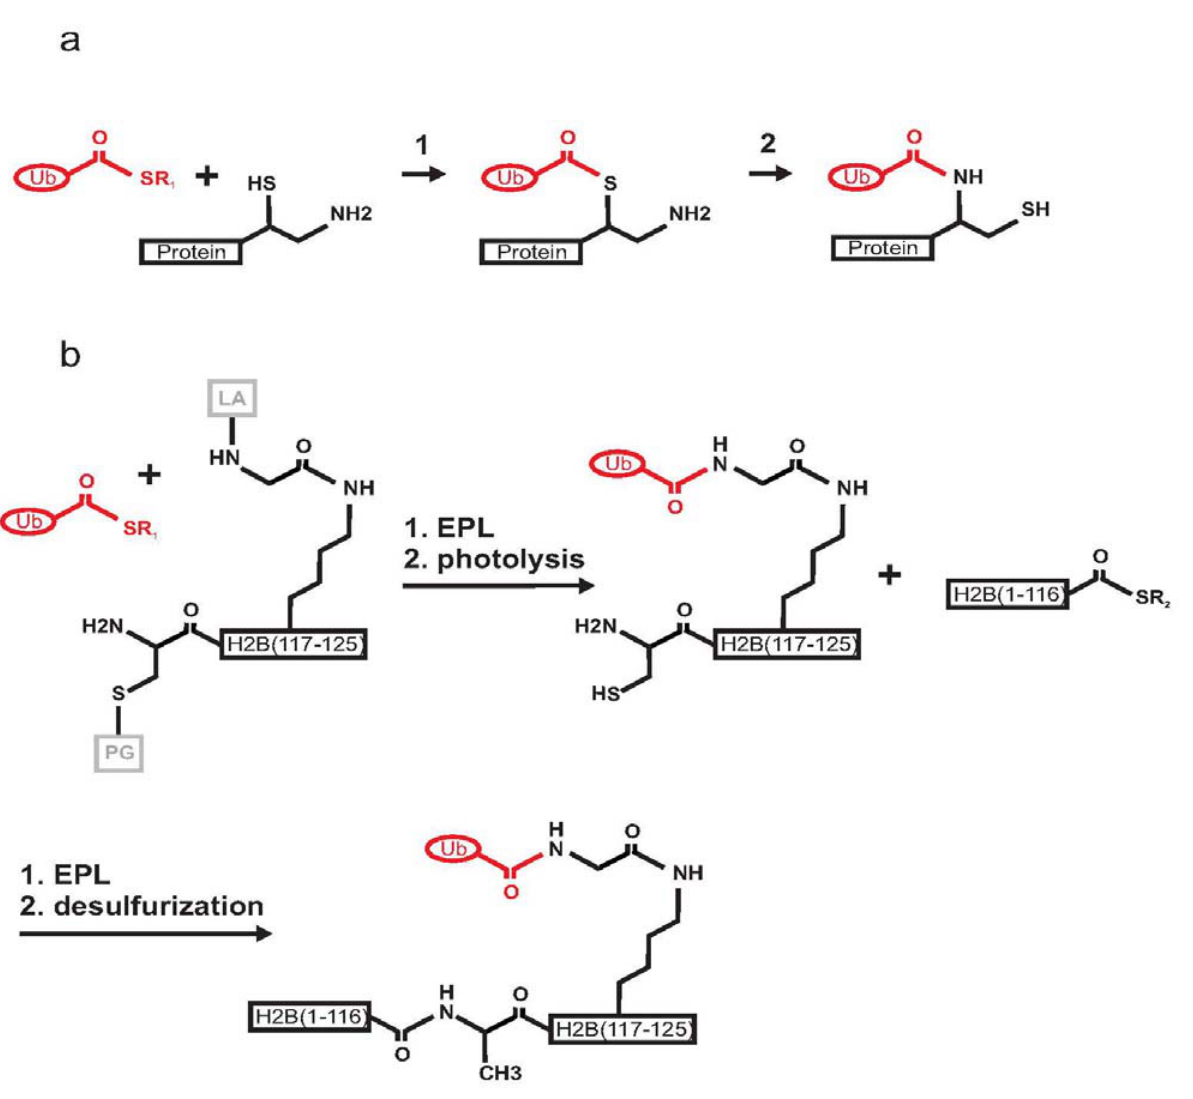
Figure 3. Schematic mechanism of expressed protein ligation (EPL) between Ub C-terminal- α -thioester and a protein having a 1,2-aminothiol group. ( a ) Reaction 1: transthioesterification step; Reaction 2: S-to-N acyl shift resulting in the formation of a native isopeptide bond. ( b ) Scheme of the semisynthesis of mono-ubiquitinated histone H2B. Ub (1–75) is in red, the two fragments forming H2B are in black, the cysteine protective group (PG) and the ligation auxiliary (LA) are in grey. The recombinant Ub C-terminal- α -thioester was ligated by EPL with an auxiliary linked synthetic peptide H2B (117–125). Photolysis allowed the removal of the ligation auxiliary and of the cysteine protective group. A second EPL step led to the ligation of recombinant H2B (1–116). Finally, mono-ubiquitinated H2B is formed by cysteine